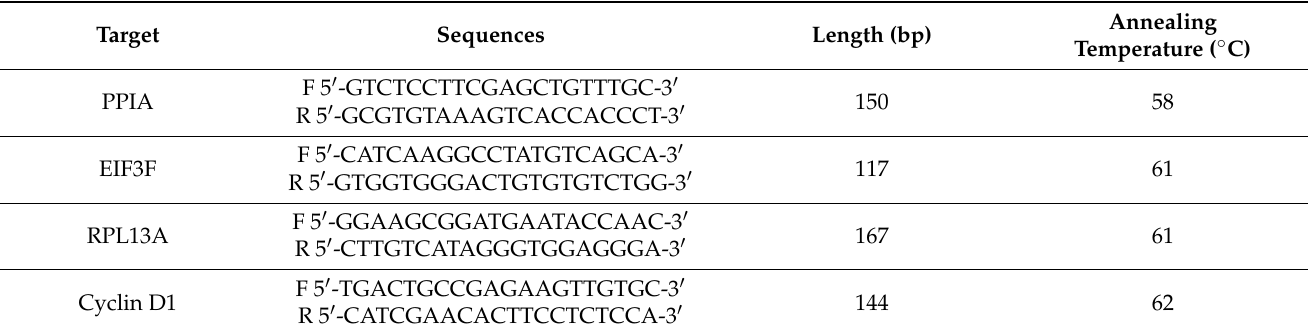
Table 1. Primers used to perform RT-qPCR.